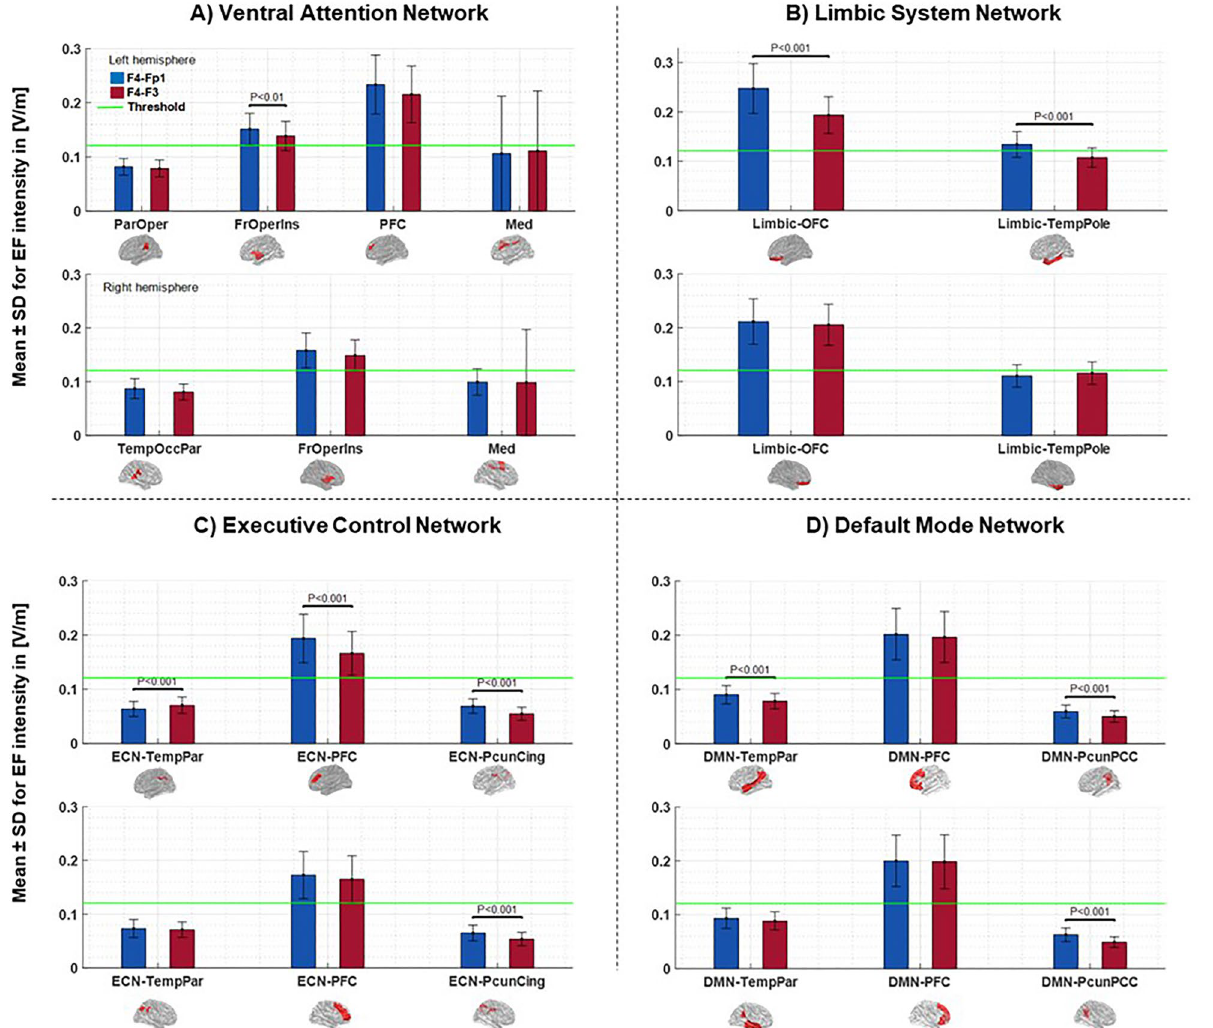
Figure 7. EF intensity in the main nodes of the large-scale brain networks at a current of 2 mA generate by each montage. Bars show mean values and error bars represent SDs of the EF intensity in volt per meter ([V/m]) across 66 participants inside the main nodes of large-scale networks for F4–Fp1 (blue bars) and F4–F3 (red bars) electrode montages in the left and right hemisphere of each network. Each network in Yeo7-atlas that received EFs above the threshold including ( A ) ventral attention network, ( B ) limbic system network, ( C ) executive control network, and ( D ) default mode network parcellated into subregions based on Schaefer201 8_100Parcells_7networks atlas and main nodes of each network were extracted by averaging the EFs in the subregions of the main nodes. Labels below the horizontal axis denote the name of main nodes inside the large- scale network and small brains next to the labels represent the spatial location of the main nodes in fsaverage space. Significant differences between the two montages are shown above the bars based on the t-test with FDR correction threshold at P < 0.05. The horizontal green line indicates EF threshold (50% minimum value of the 99th percentile of EFs in whole-brain analysis across the subjects). EF electric field, SD standard deviation, FDR false discovery rate, VentAtn ventral attention network, Limbic limbic system network, ECN executive control network, DMN default mode network, OFC orbitofrontal cortex, TempPole temporal pole, TempPar Tempro- parietal, PFC prefrontal cortex, PcunCing precuneus-cingulate cortex, PcunPCC precuneus-posterior cingulate